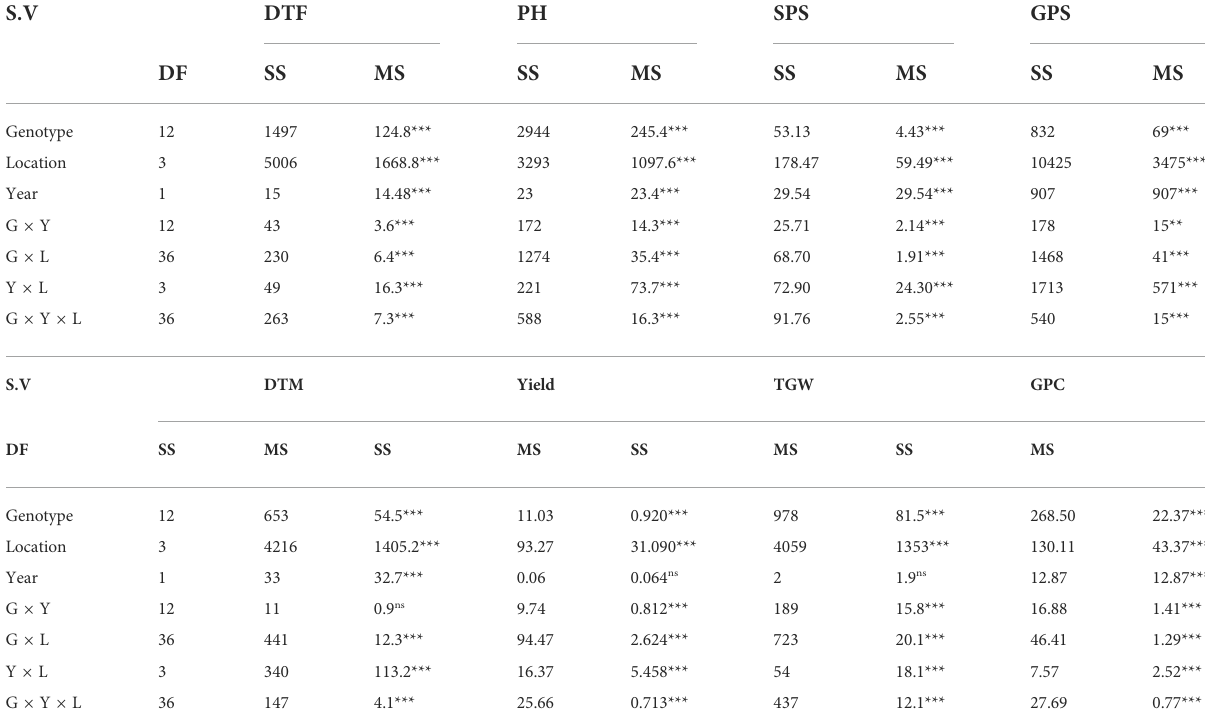
TABLE 3 Combined analysis of variances for grain protein content, yield and key yield-related traits of 13 bread wheat genotypes across eight environments.